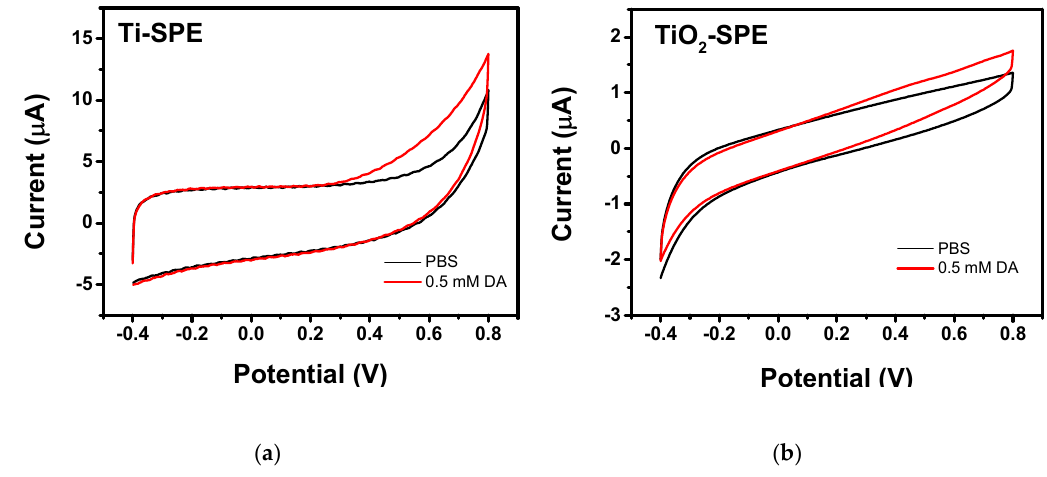
Figure 6. CVs of ( a ) bare Ti-SPE and ( b ) TiO 2 -nanoporous SPE in PBS (pH = 7.0) in the absence and presence of 0.5 mM DA. Scan rate is 50 mV s −1 .